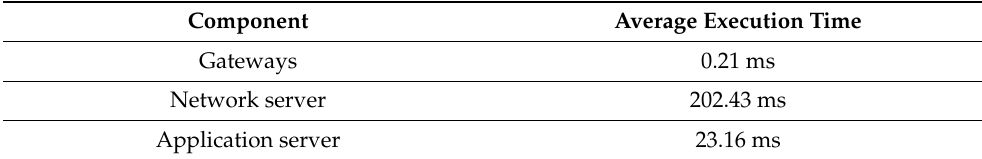
Table 3. Average Execution Time of the Fog Components for 10,000 Requests.